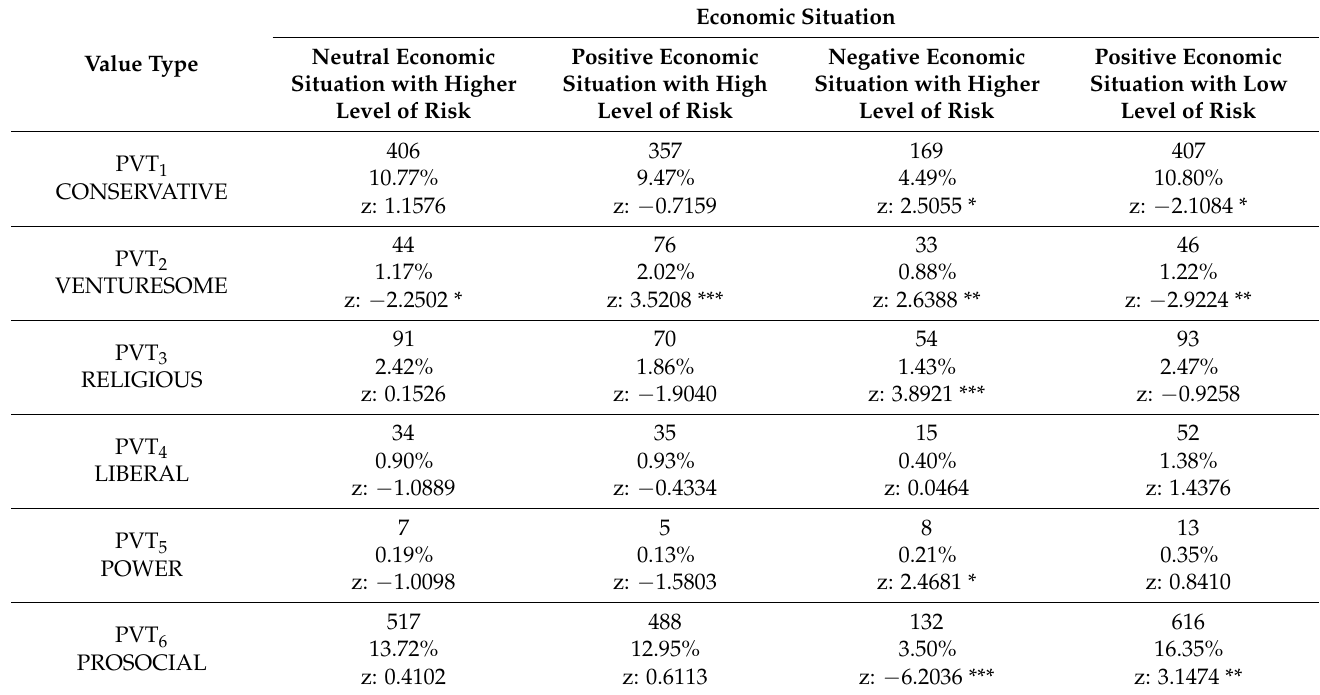
Table 6. ES/PVT and standardized residuals (z-score) for each